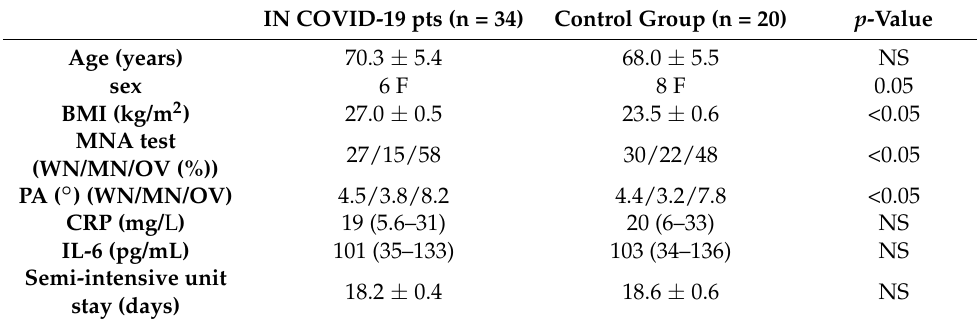
Table 1. Characteristics of the study and control populations at T0.